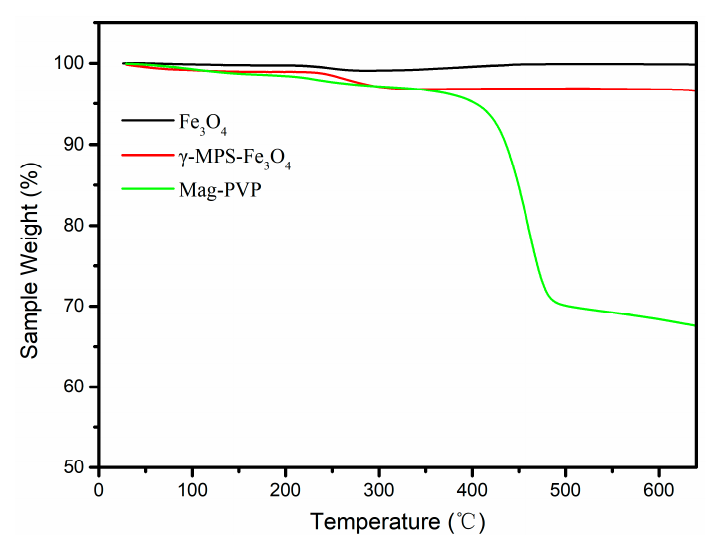
Figure 4. Thermogravimetric analysis (TGA) of Fe 3 O 4 , γ -MPS-Fe 3 O 4 , and Mag-PVP.